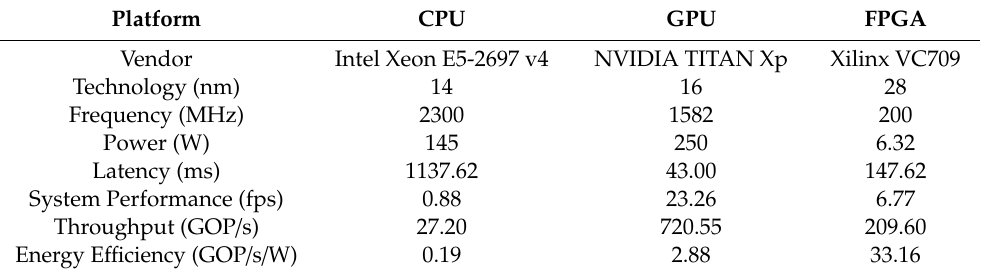
Table 4. Evaluation results on the Central Processing Unit (CPU), Graphic Processing Unit (GPU) and our accelerator.